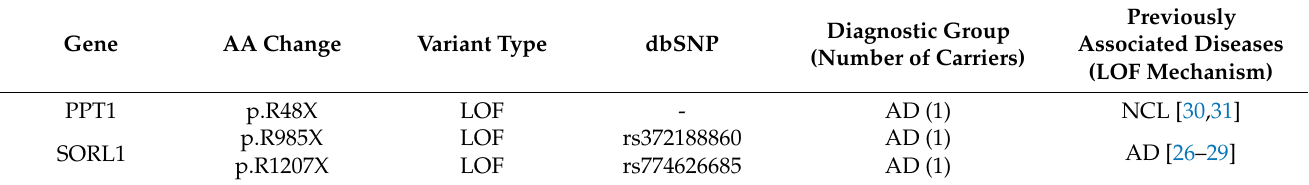
Table 3. Predicted null variant in genes where LOF is a known mechanism of the disease.